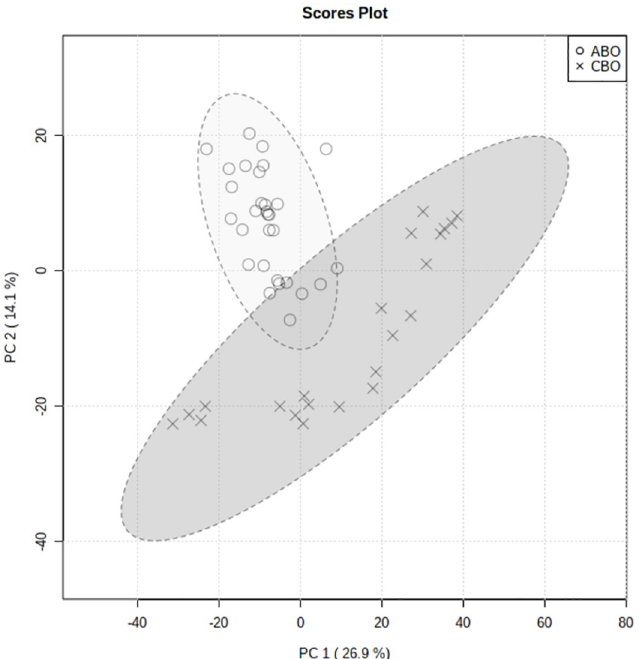
Fig 3. PCA scores plot between the Comp1 and Comp2.